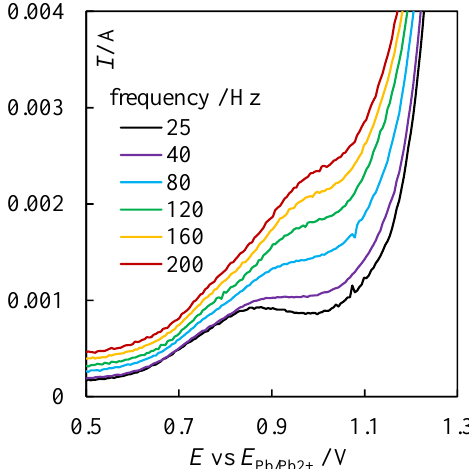
Figure 10. CVs in the PbCl 2 – 0.044 wt% PbO melt at a potential sweep rate from 0.1 to 2 V s −1 and a temperature of 520 ° C.